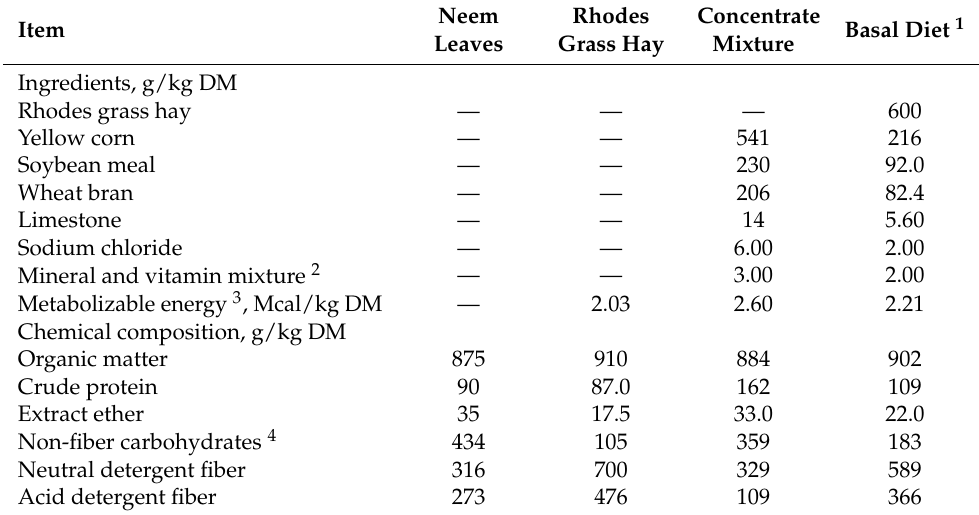
Table 1. Feed ingredient proportions and chemical composition of experimental diets on a dry matter basis (g/kg DM).